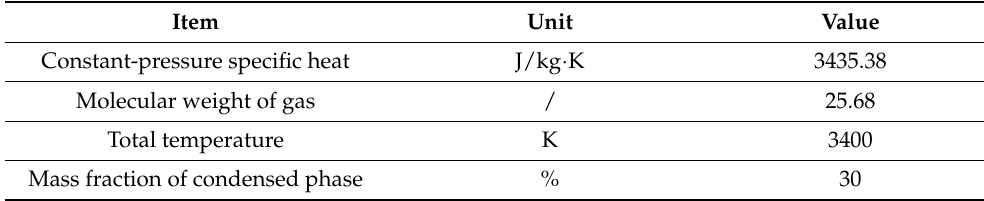
Figure 2. The model for calculations (The burning surface of the propellant grain is retreating): ( a ) The calculation model at t = 2 s; ( b ) The calculation model at t = 7 s; ( c ) The calculation model at t = 14 s. Table 1. The parameters for the